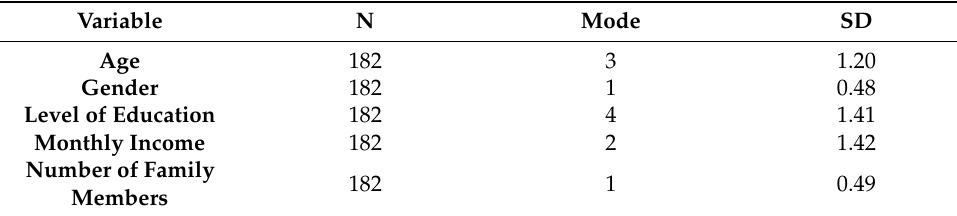
Table 4. Descriptive statistics for the sample.